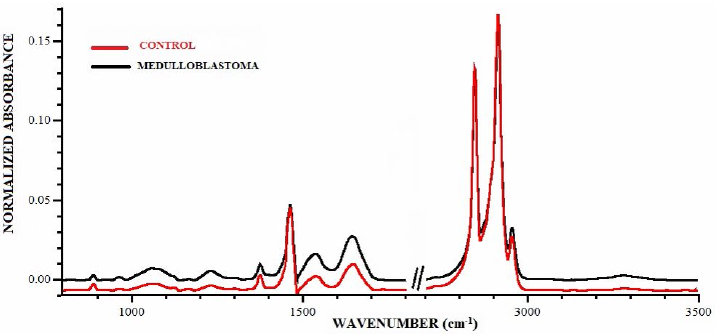
Figure 1. FTIR spectra of mean malignant cancer tissue of brain—medulloblastoma (black) and mean of control group (red). Measuring range 800–3500 cm −1 . Table 1. Peak vibrational frequencies observed in the FTIR spectra of the different histological sub- types in FTIR spectra and their associated biochemical assignments [9–13]. Desmoplastic Anaplastic Control Classic Subtype Subtype Subtype